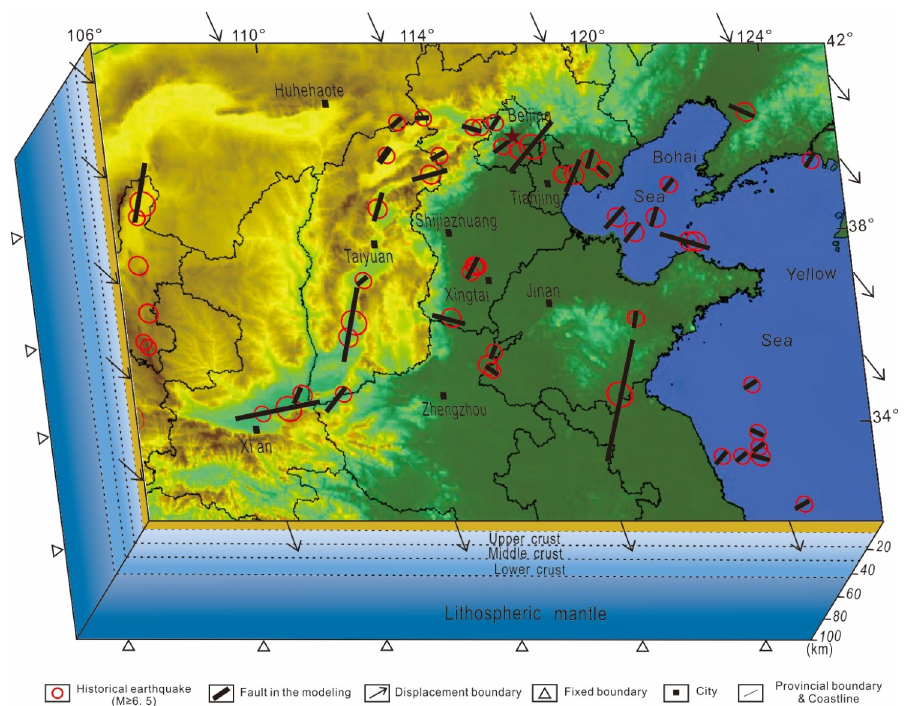
Fig 4. Geometry and boundary conditions of the model. The black lines depict the distribution of major seismogenic faults in the model (after Shen et al., 2004). Red circles mark the locations of earthquakes (M � 6.5) since 1303; white arrows depict displacement directions of the model boundaries. The surface of the model is set free, the bottom horizontally and vertically fixed to velocity zero. https://doi.org/10.1371/journal.pone.0215893.g004 without considering the fault occurrence in the model. The coefficient of friction of the faults was taken to be 0.4 throughout our calculations.